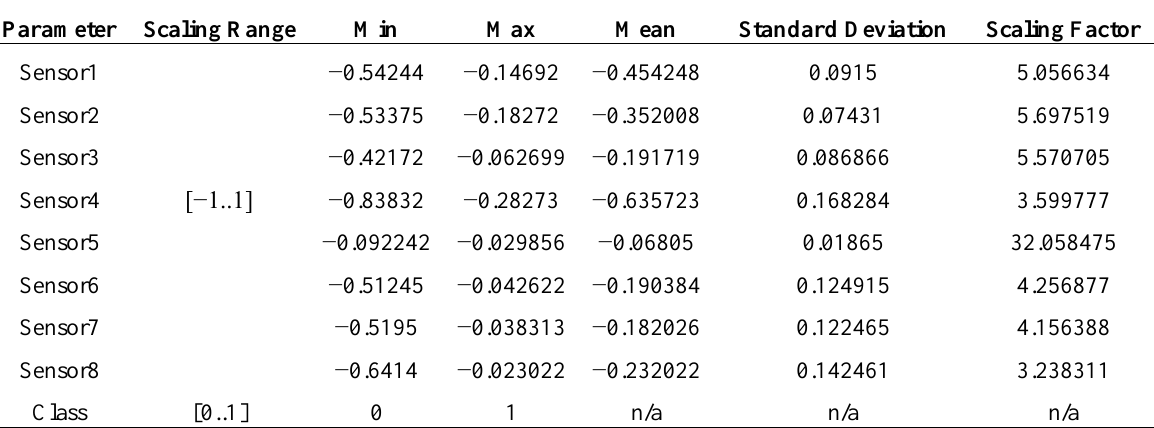
Table 5. The preprocessing database.